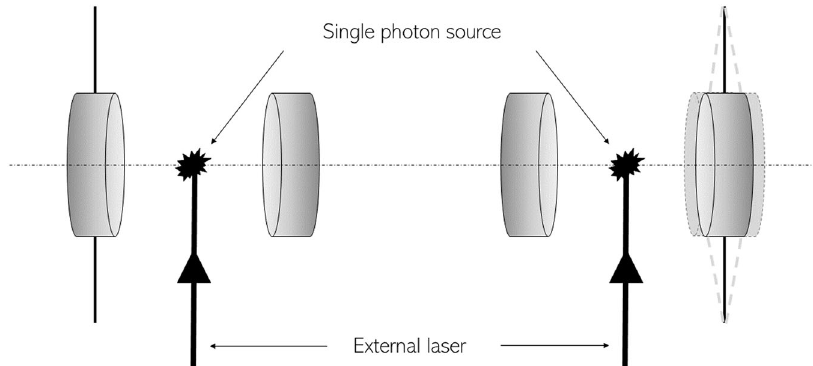
Fig. 3 Optomechanical apparatus for the experimental test of quantum gravitational decoherence. The left cavity has two fi xed mirrors, whereas the right cavity contains a movable mirror. The same external laser excites two atomic (or molecular) systems that act as sources of entangled photons when they decay back to their respective ground states emitting in the process entangled photon radiation into the cavity.